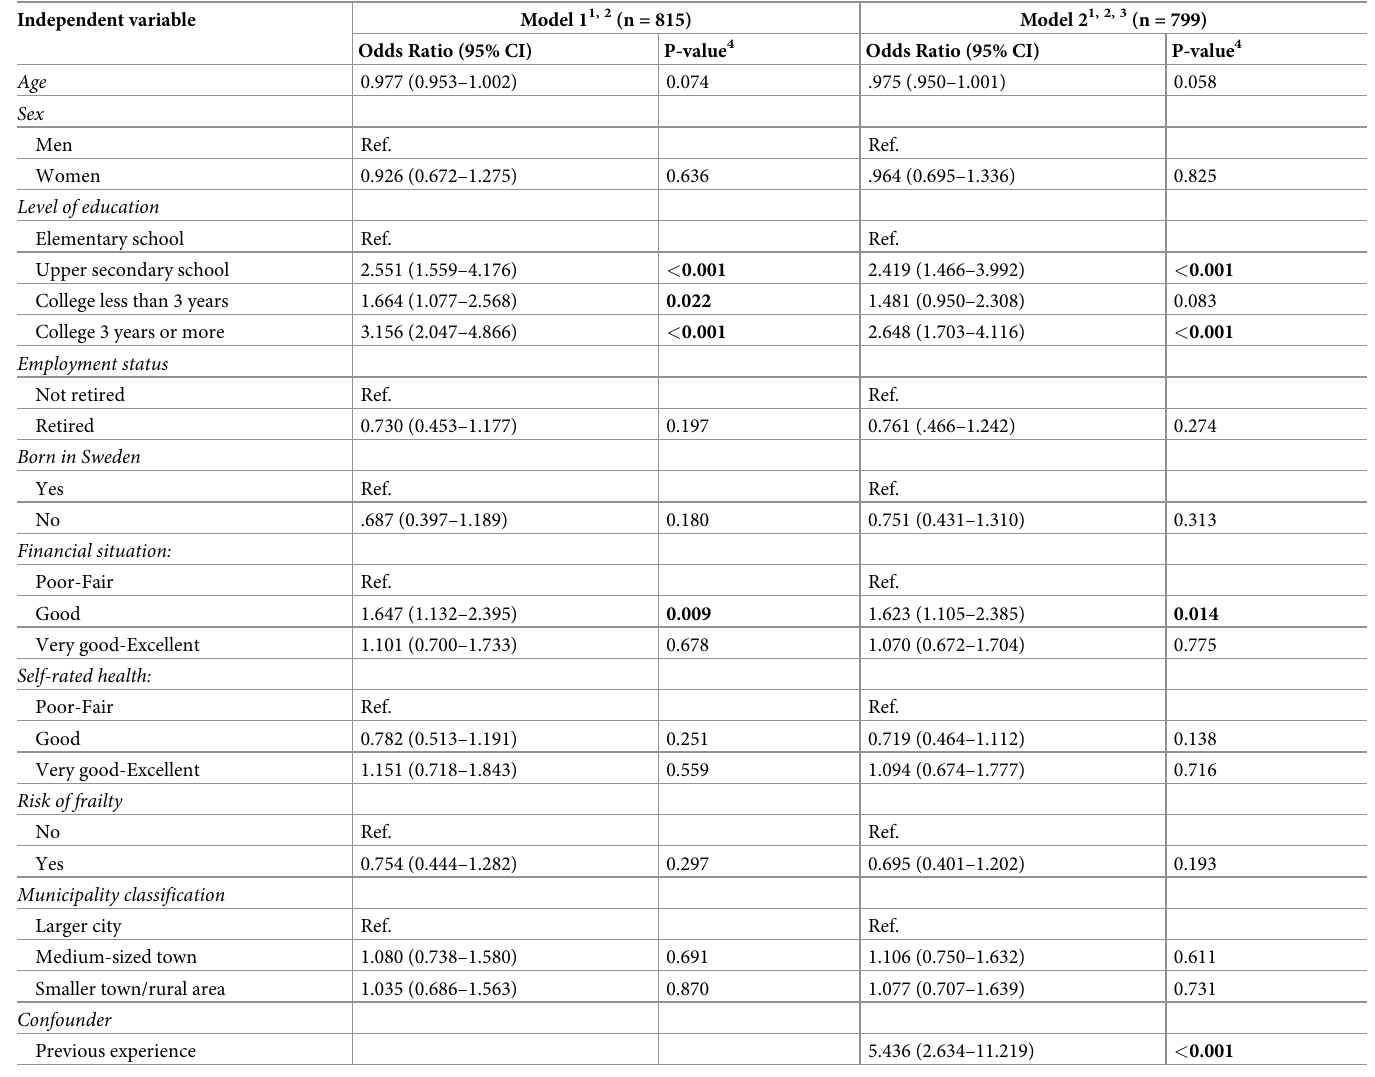
Table 2. Logistic regression results for willingness to be actively involved in